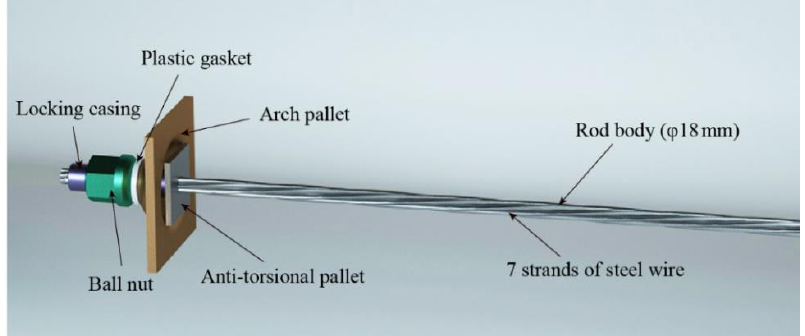
Figure 1. Schematic diagram of a flexible bolt.